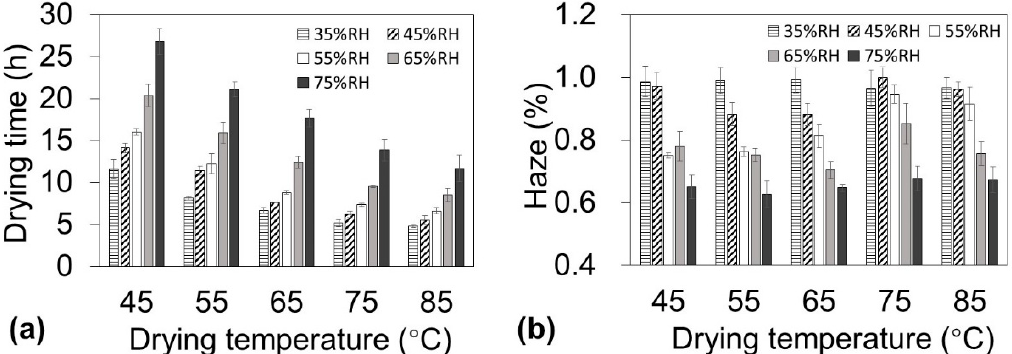
Figure 2. Drying time of nanofiber dispersions (0.45 wt %, 22 g) and haze of nanopaper with 10 ± 1 µ m thickness under various temperature and humidity conditions. ( a ) Drying time and ( b ) haze as a function of drying temperature.